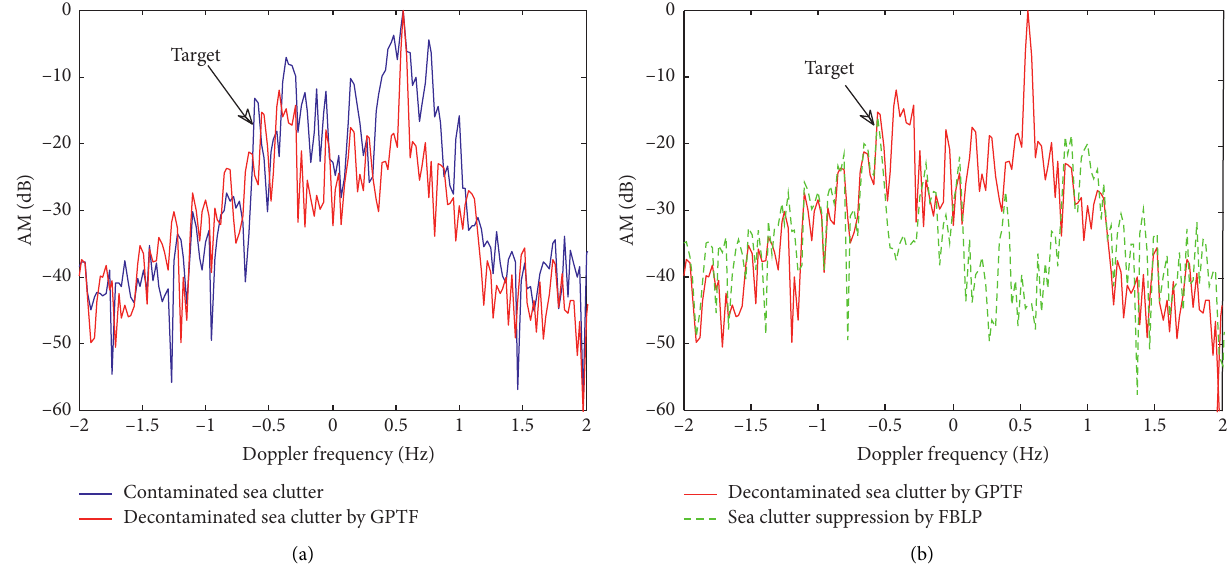
Figure 8: The broadening sea clutter suppression based on GPTF and FBLP algorithm. (a) Decontamination result by GPTF method. (b) Sea clutter suppression by FBLP.